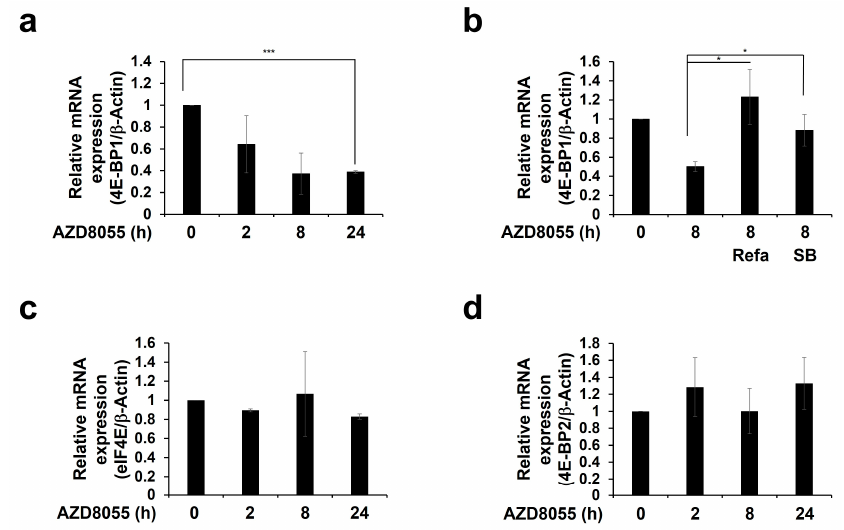
Figure 6. AZD8055 regulates the 4E–BP1 mRNA pool by up ‐ regulating ERK1/2 and p38 pathways. ( a , b ) HepG2 cells pretreated with ( b ) or without ( a ) 100 nM refametinib (Refa) or 10 μ M SB203580 (SB) for 1 h were treated with 2 μ M AZD8055 for indicated periods, and the relative mRNA expression of 4E–BP1 was determined by qPCR using specific primer. ( c , d ) Cells were treated with 2 μ M AZD8055 for 2–24 h. Endogenous levels of eIF4E ( c ) and 4E–BP2 ( d ) mRNAs were measured by qPCR. The relative expression levels of target mRNAs were determined by comparing DMSO control with the experimental group after normalization using β –Actin mRNA. The data obtained from three independent experiments were presented as means ± S.D. Statistically significant differences were calculated using Student’s t -test and indicated as * p < 0.05 and *** p <